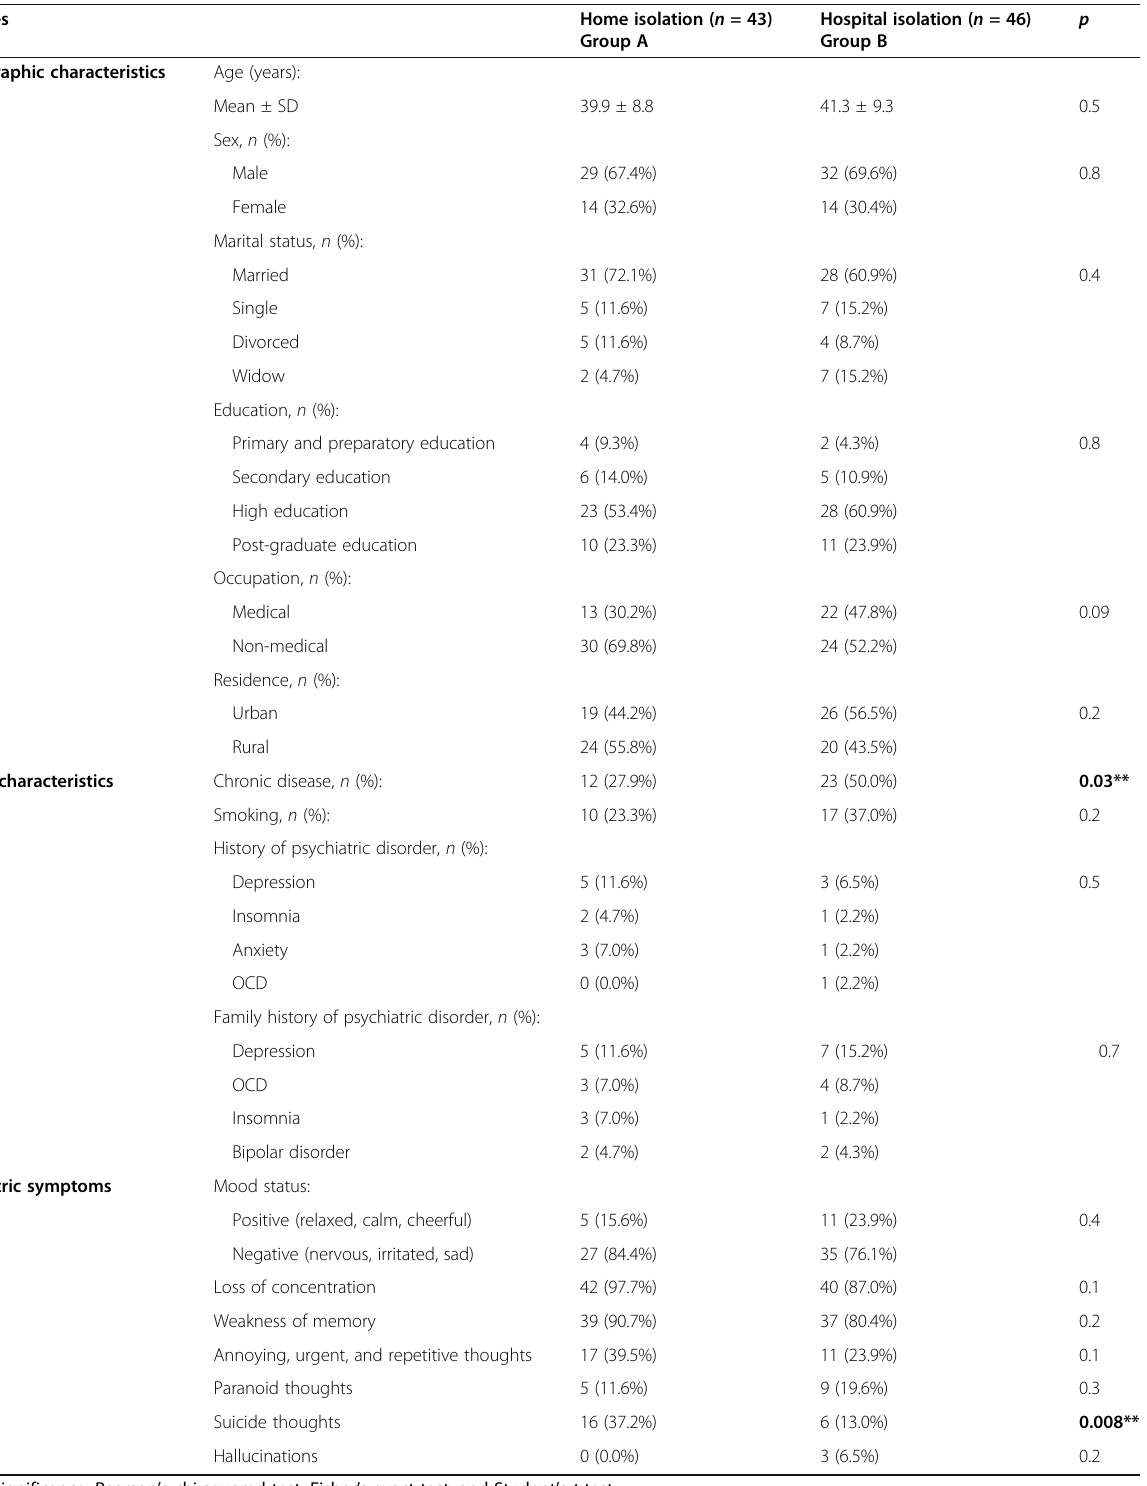
Table 1 Comparison between home-isolated patients and hospital-isolated patients in demographic, clinical characteristics, and psychiatric symptoms